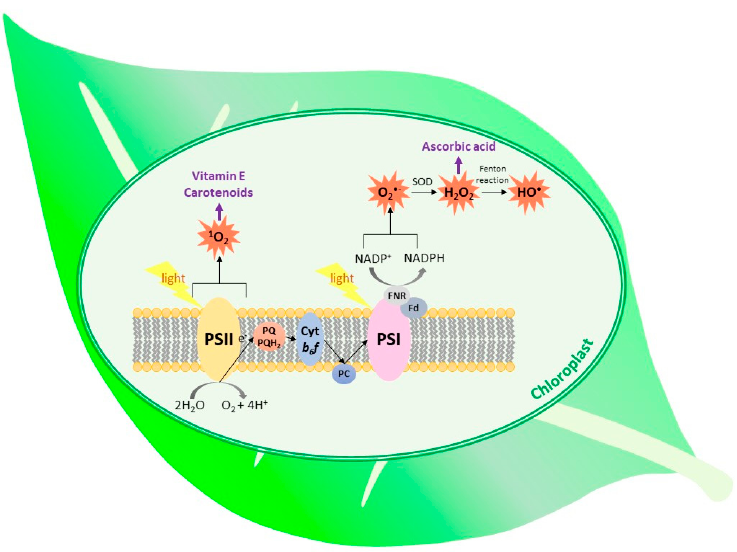
Figure 1. The types of ROS generated within the thylakoid membrane and place of action of the selected antioxidants. (SOD, superoxide dismutase; Fd, ferredoxin; FNR, ferredoxin–NADP + reductase; PC, plastocyanin; cyt b 6 f , cytochrome b 6 f